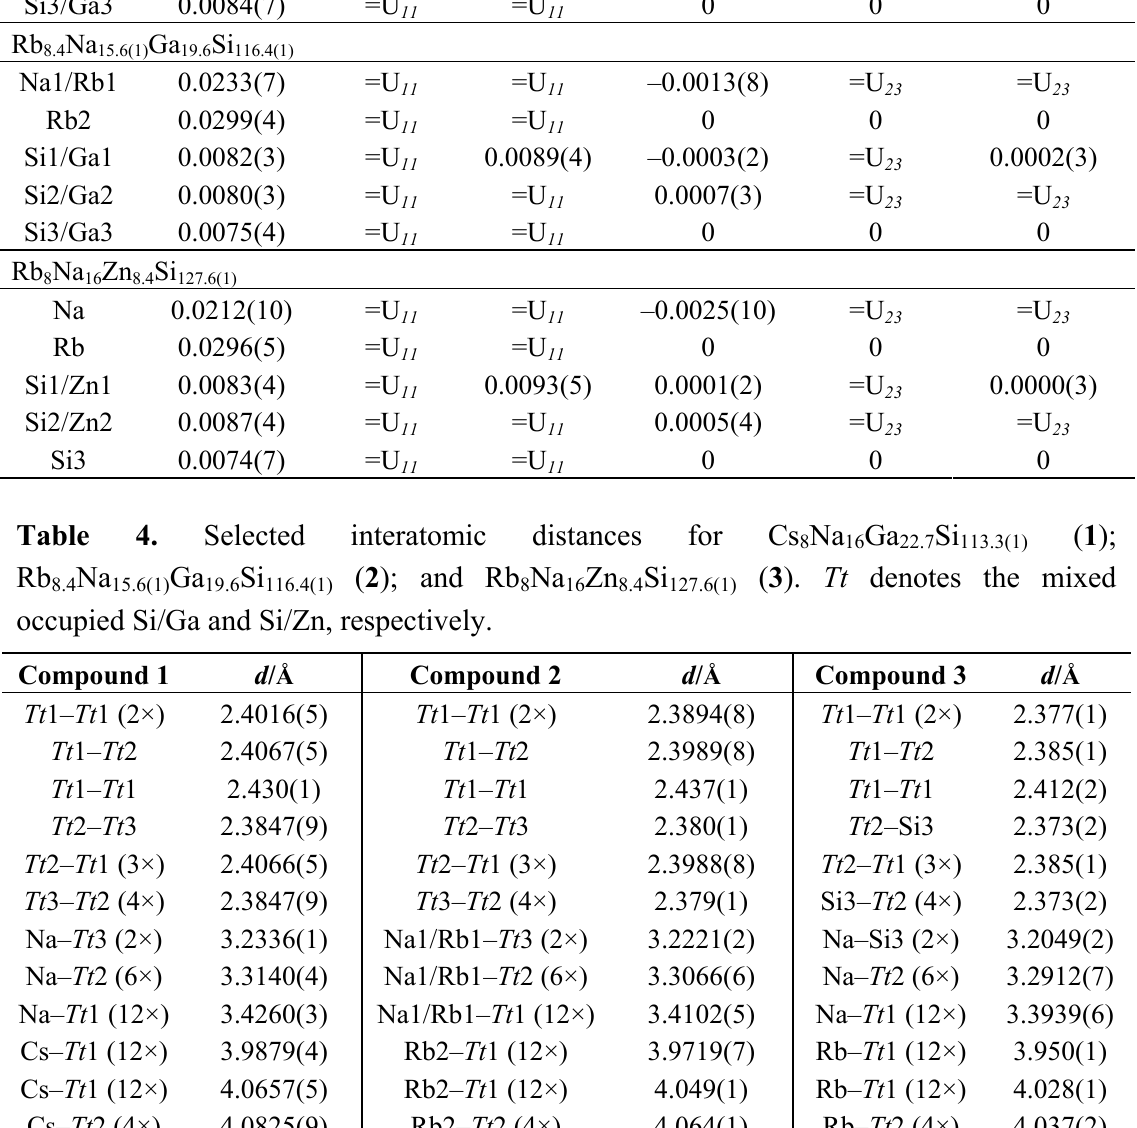
Na Ga Si ( 1 ); 8 16 22.7 113.3(1)